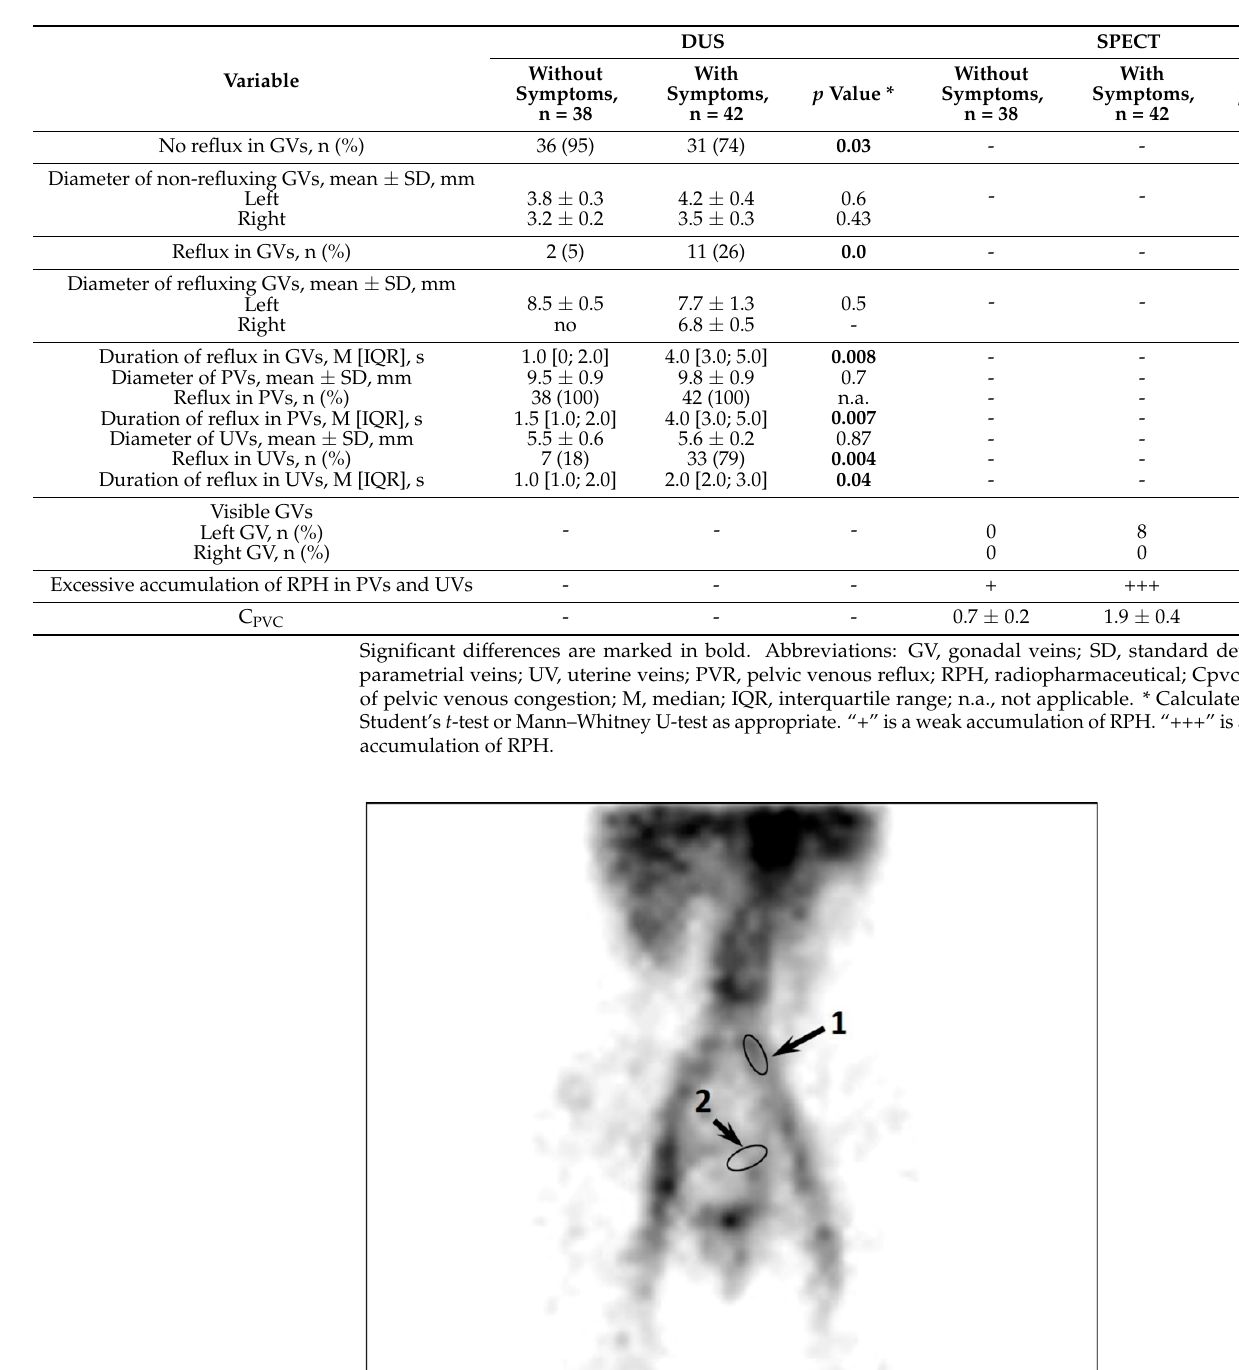
Table 2. Results of ultrasound and radionuclide studies in asymptomatic and symptomatic patients with PeVD (N = 80).